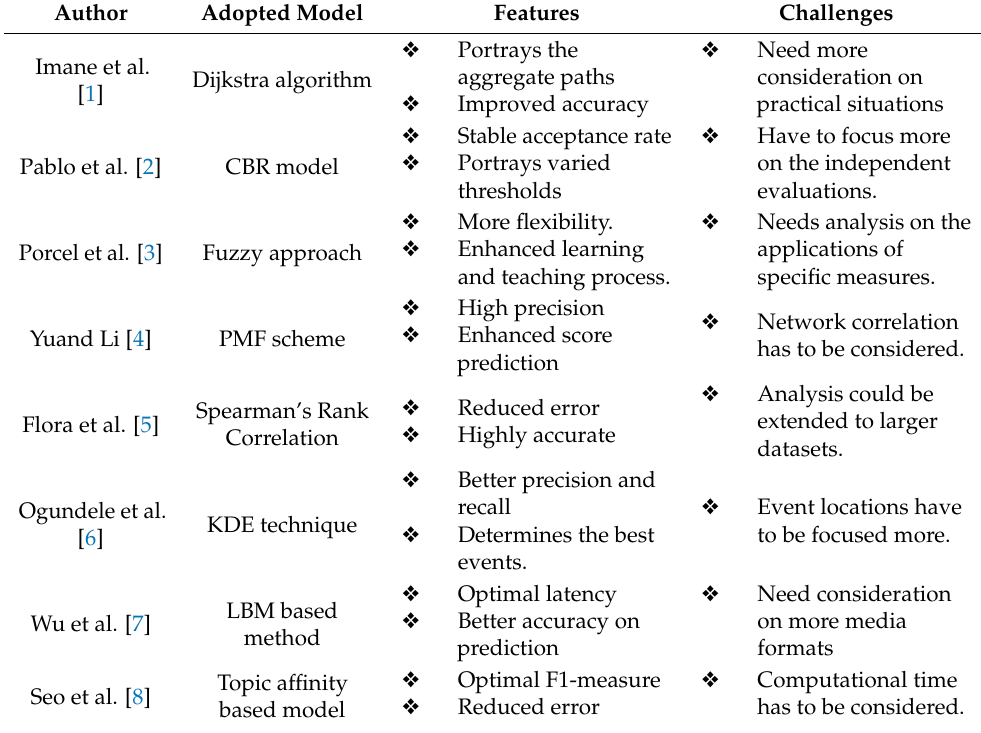
Table 1. Reviews on conventional IoT based healthcare